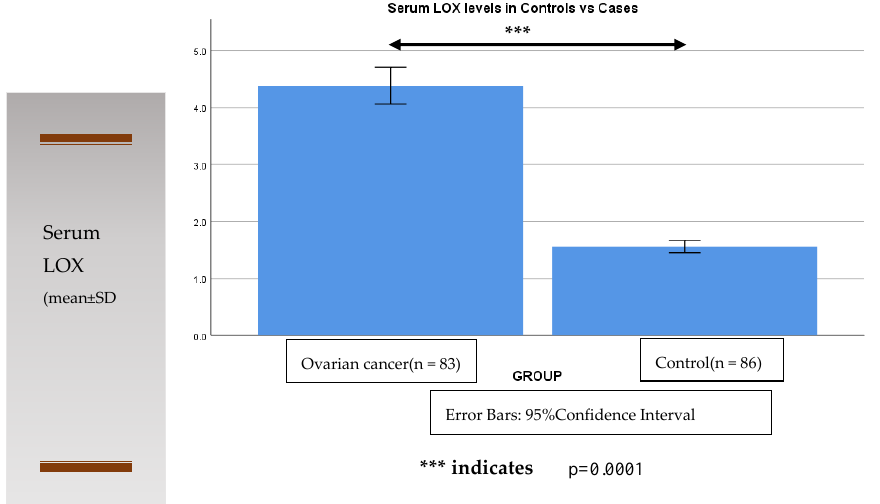
Figure 1. Comparison of serum LOX levels in control to ovarian cancer cases. On subgroup analysis, based on the clinical severity of the ovarian cancer patients, i.e., FIGO Stage and TNM grade, it was observed that in early stage ovarian cancer pa- tients (with FIGO stage I and II) the serum levels of lysyl oxidase (LOX) were found to be 3.28 + 0.66 ng/mL, and with TNM grade I and II the measured LOX level was 3.42 ± 0.78 ng/mL. In advanced stage ovarian cancer (with FIGO stage III,IV), the value was found to be 5.01 ± 1.05 (as per the TNM grade i.e., Grade-3, measured 4.89 ± 1.16)(Table 2).The